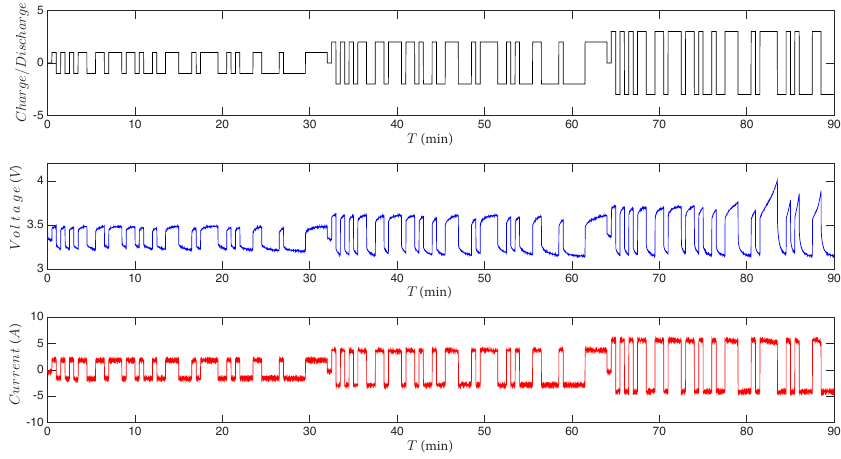
Figure 6. Charge/discharge cycles, voltage and current experimental results in 90